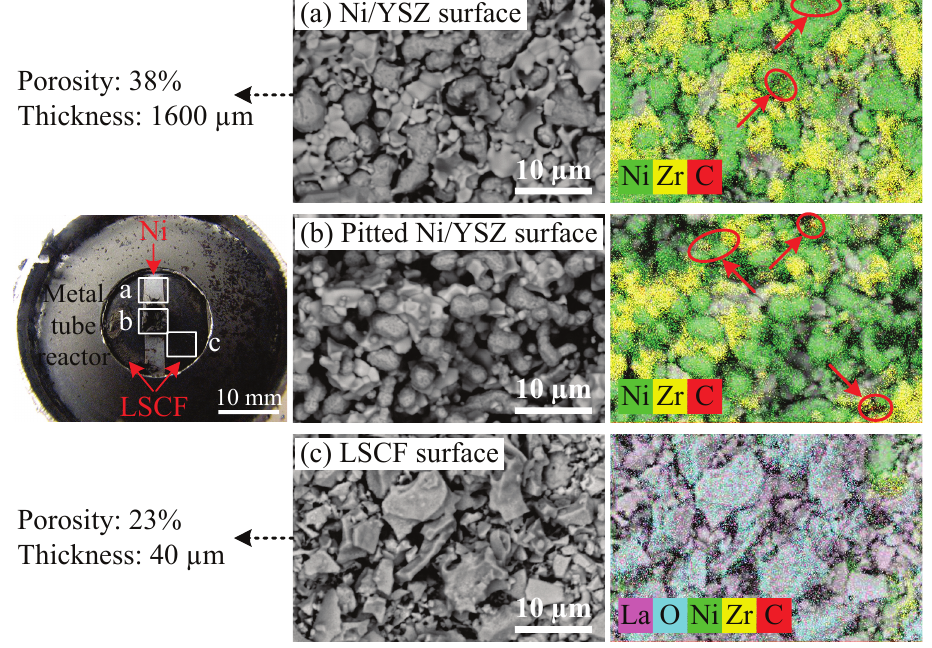
Figure 7. Image of the LSCF-Ni/YSZ anode on the cut-off piece of the metal tube reactor after stability test in CH , and SEM micrograph/ EDX mapping of the ( a ) Ni/YSZ surface; 4 ( b ) cracked region on the Ni/YSZ surface; and ( c ) LSCF surface. The location of carbon is highlighted with red circles.